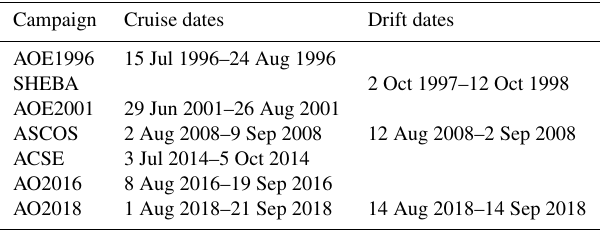
Table 1. Overview of cruise dates for AO2018 and the previous campaigns shown in Fig.